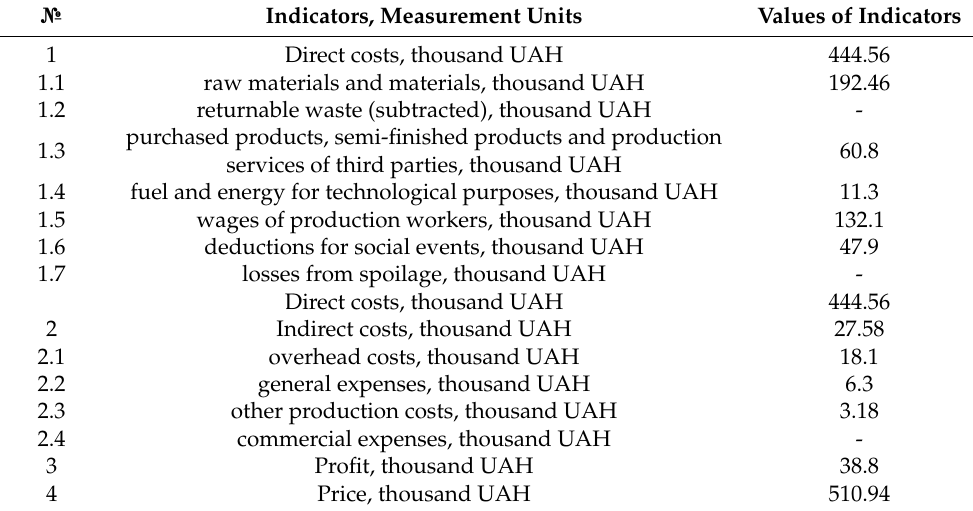
Table 3. Price structure for the device of the interferometric determination of the refractive index of crystalline materials in the optical range 1